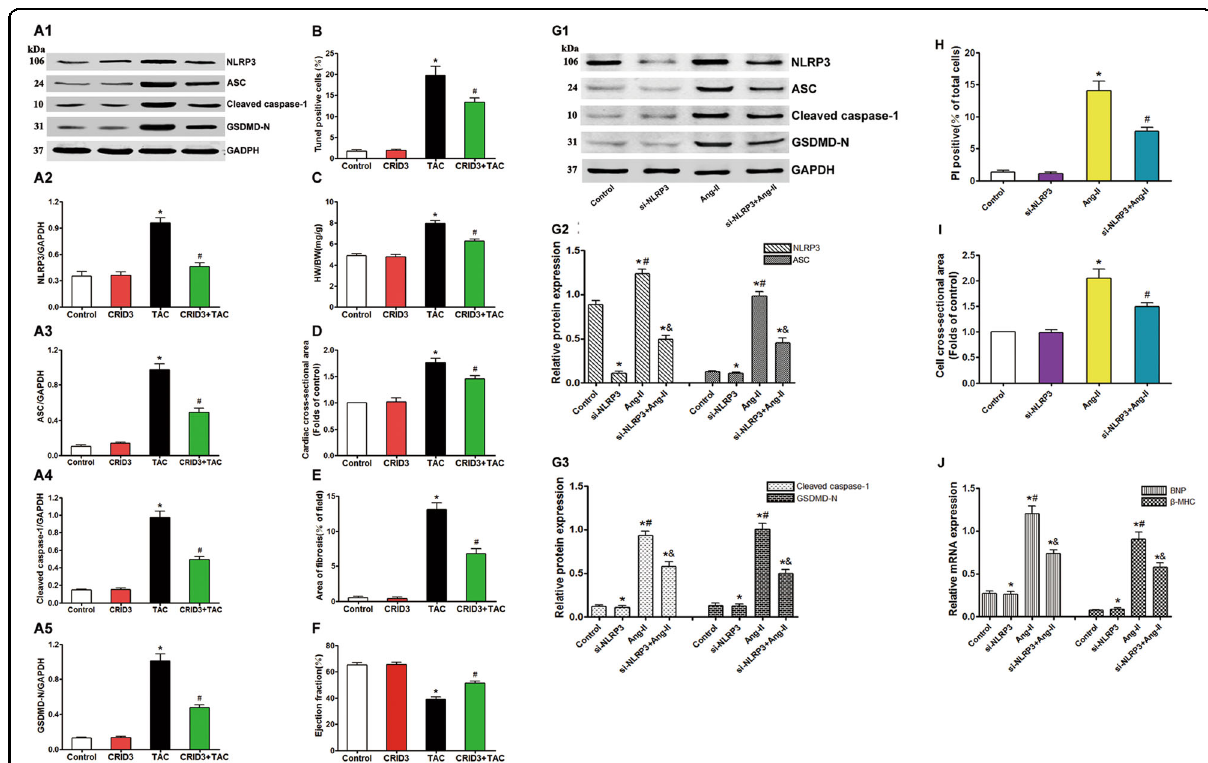
Fig. 5 NLRP3 inhibitor CRID3 or knockdown NLRP3 with si-RNA decreased pyroptosis and attenuated cardiac hypertrophy induced by TAC or Ang-II. A Immunoblots showing the protein levels of NLRP3 ( A1 , A2 ), ASC ( A1 , A3 ), cleaved caspase-1 ( A1 , A4 ), and GSDMD-N ( A1 , A5 ) in the cardiac tissue of indicated groups. B Percentage of TUNEL-positive cells in the indicated groups. C Proportion of heart to body weight in the indicated groups. D Quanti fi cation of the cross-sectional area of cardiomyocytes of the left ventricle in the indicated groups. E Quanti fi cation of the myocardial fi brosis in the indicated groups. F Quantitative analysis of left ventricular EF in the indicated groups. G Immunoblots showing protein levels of NLRP3 and ASC ( G1 , G2 ), cleaved caspase-1, and GSDMD-N ( G1 , G3 ) in the suitably treated cardiomyocytes. H Percentage of PI-positive cells in the suitably treated cardiomyocytes. I Measurement of the cell surface area of cardiomyocytes in the indicated groups. J mRNA expression of cardiac hypertrophy markers BNP and β -MHC in the suitably treated cardiomyocytes. Results are presented as the mean ± SEM, n = 6. ∗ P < 0.01 compared to control, # P < 0.01 compared to TAC or Ang-II group. CRID3 (cytokine release inhibitory drug 3, NLRP3 inhibitor) known as CP-456773 or